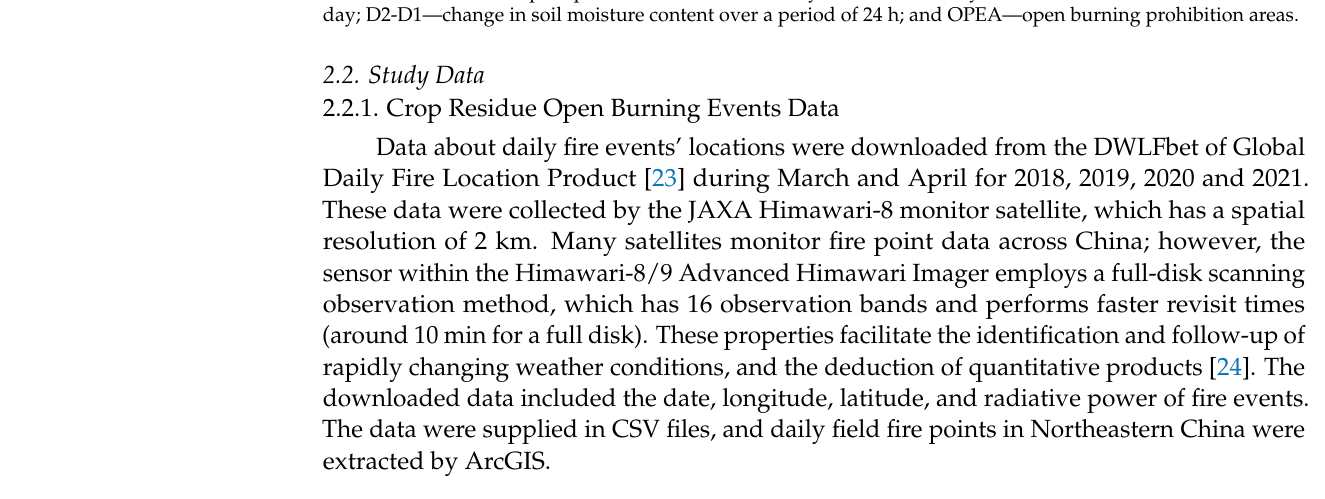
Table 1. Detailed information about the input data used in this study.